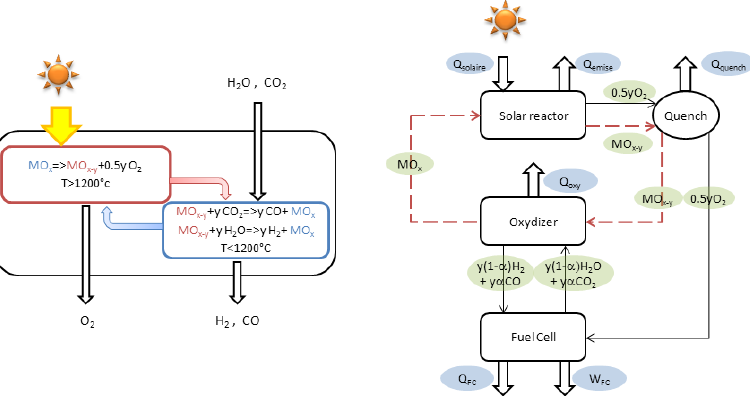
Figure 3. Mass and energy flow diagrams for a typical two-step thermochemical cycle.